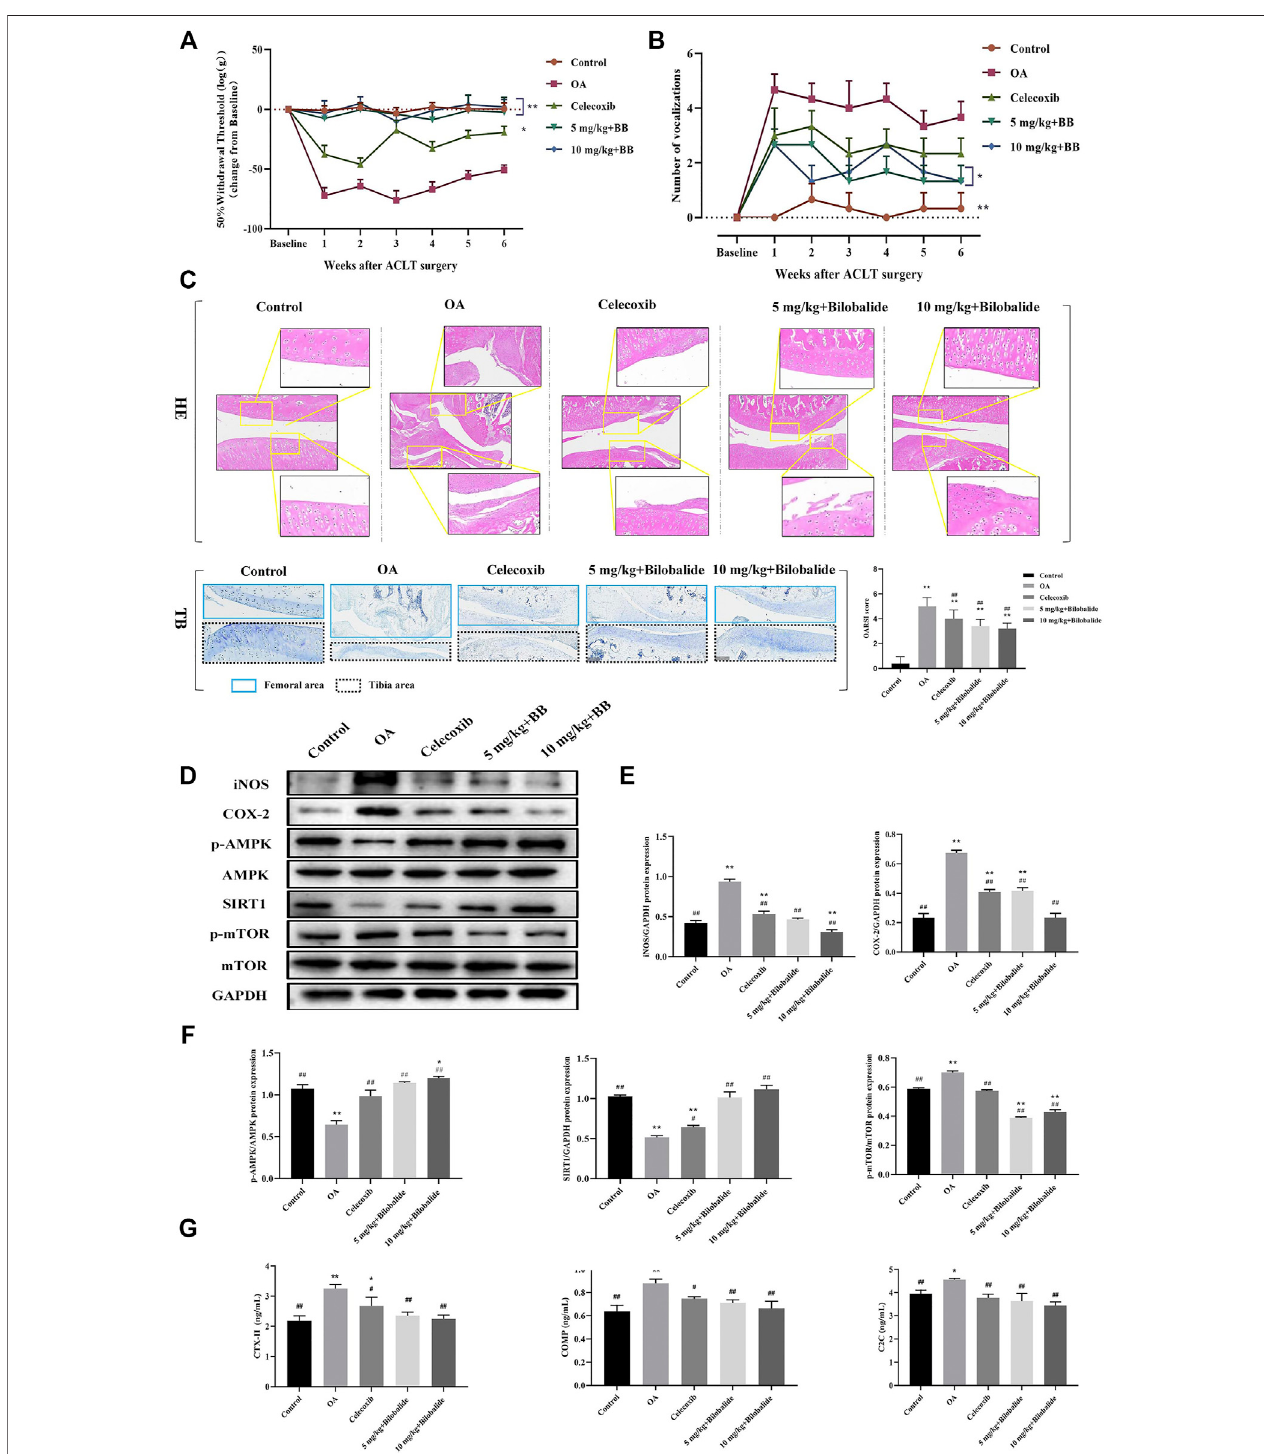
FIGURE 6 | Bilobalide attenuates ACLT-induced PTOA in rats via AMPK/SIRT1/mTOR pathway. (A) Mechanical sensitivity. (B) Vocalizations evoked by extension of the knee. (C) Representative images of the knee joint stained with hematoxylin-eosin (HE) and toluidine blue (TB) and OARSI scores after 6 weeks of treatment. Magni fi cation ×10. (D – F) Western blot analysis of AMPK/SIRT1/mTOR pathway related proteins expression in rat cartilage. (G) The levels of ECM degradation biomarkers CTX-II, COMP, and C2C in the serum of rats after bilobalide intervention were determined using ELISA. All data were presented as mean ± SD ( n = 3). * p < .05 and ** p < .01 compared to the control group; # p < .05 and ## p < .01 compared to the IL-1 β group (Statistical analysis using one-way ANOVA and paired two- tailed Student ’ s t-test).